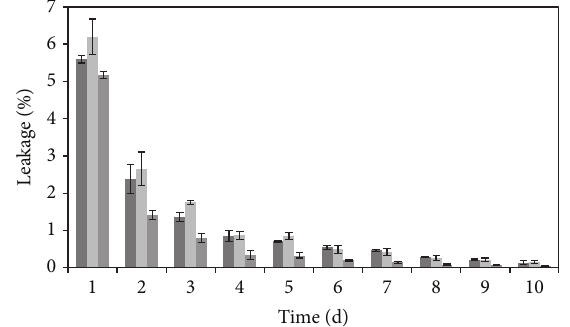
Figure 8: The storage buffer of CPO sol-gel beads prepared with casting buffers at pH 4.5 (dark grey bars), 5.5 (grey bars), and 6.5 (light grey bars) was exchanged on a daily basis and monitored for CPO activity. All samples were prepared in triplicate with eight CPO sol-gel beads per sample tube. The bar height represents the mean value and the error bar ± one standard